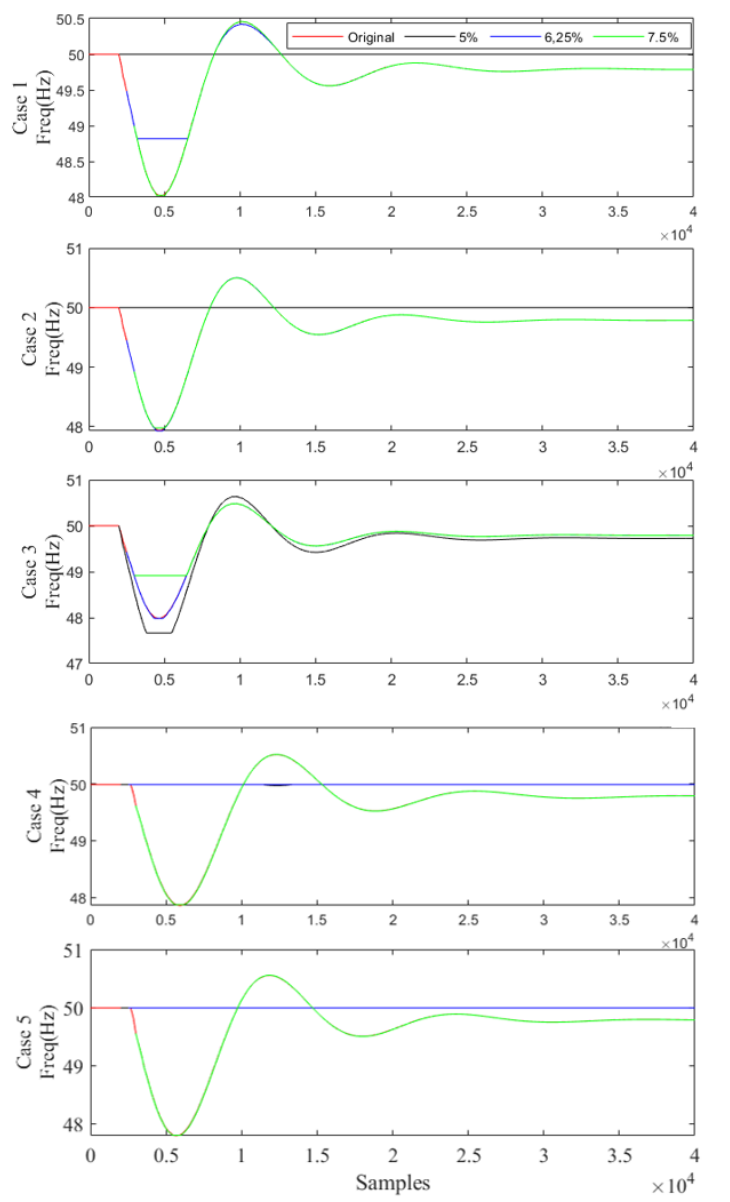
Figure 8. Results for the NAR models in all simulation